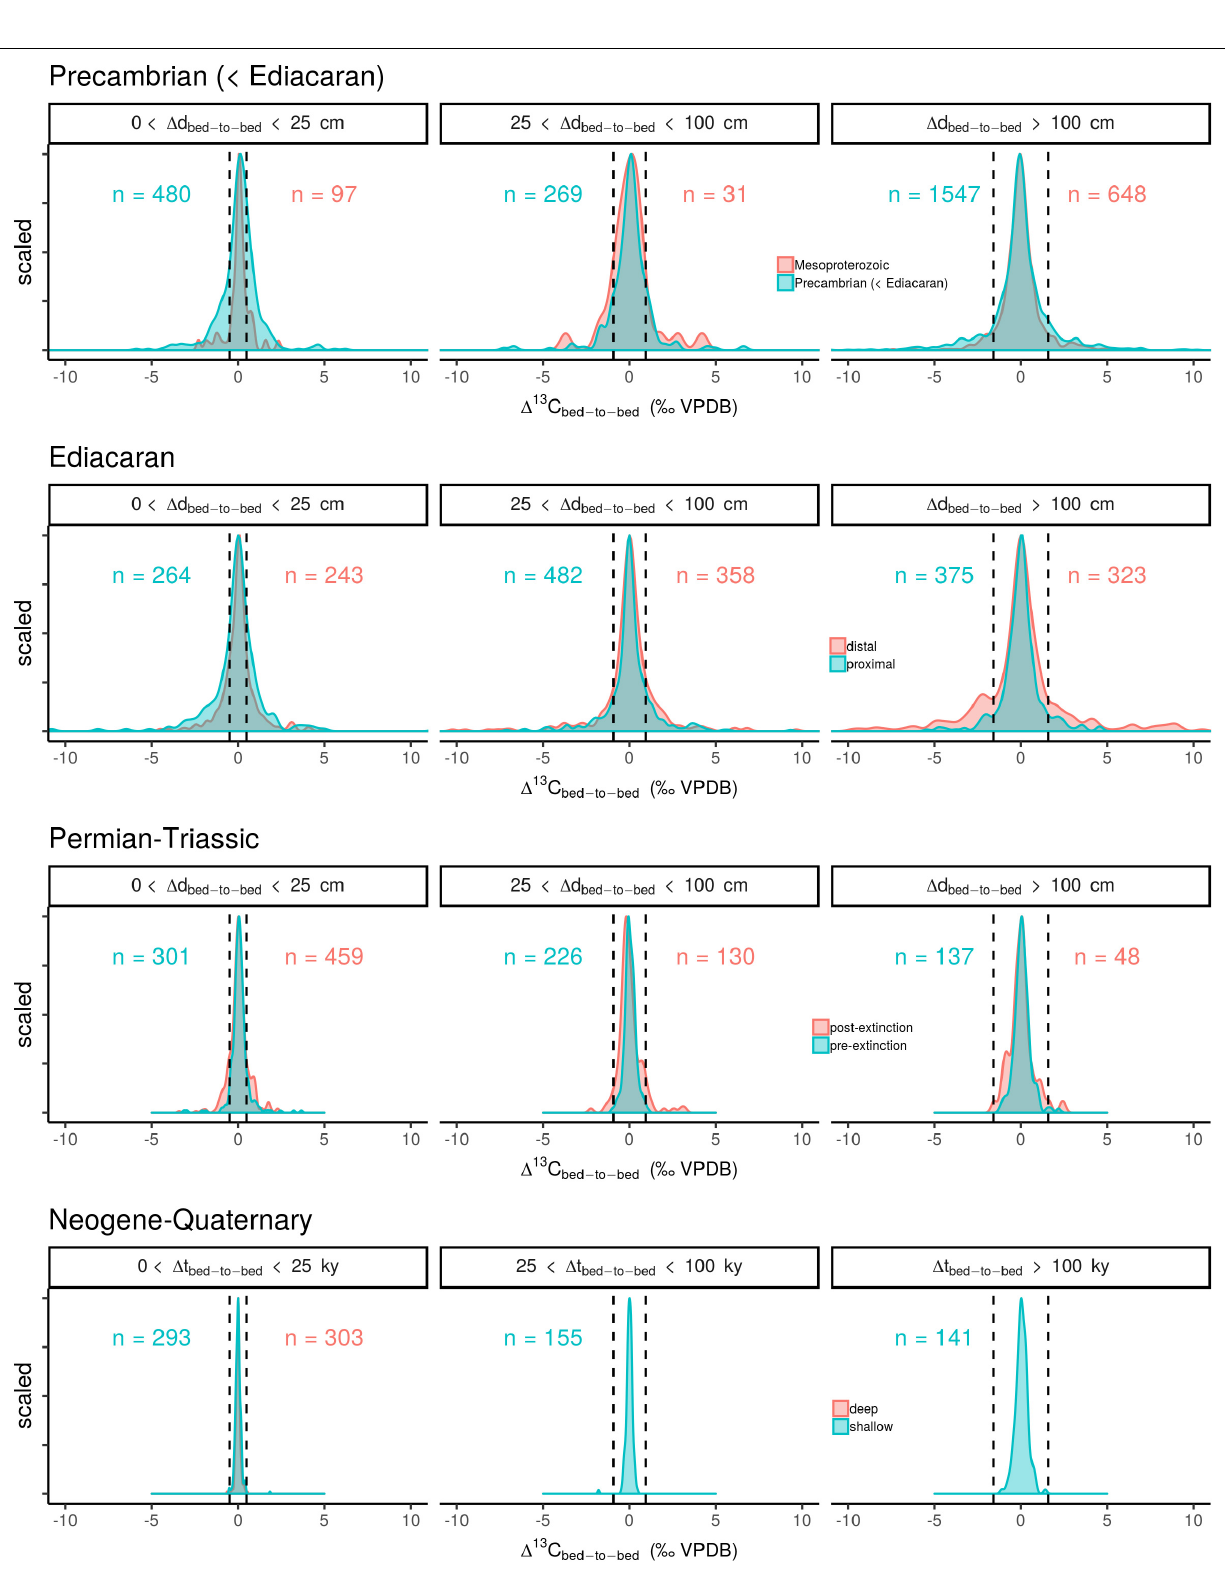
FIGURE 1 | Scaled frequency distributions of (cid:49) 13 C bed − to − bed , variation for different time intervals and filtered for several bandwidths relating to stratigraphic and temporal resolution of the sampled transects. The dashed line represent the maximum attainable variation in δ 13 C carb forced by a two times modulation to lower and higher values for the OC burial flux ( f ), whilst maintaining the other flux and reservoir sizes.